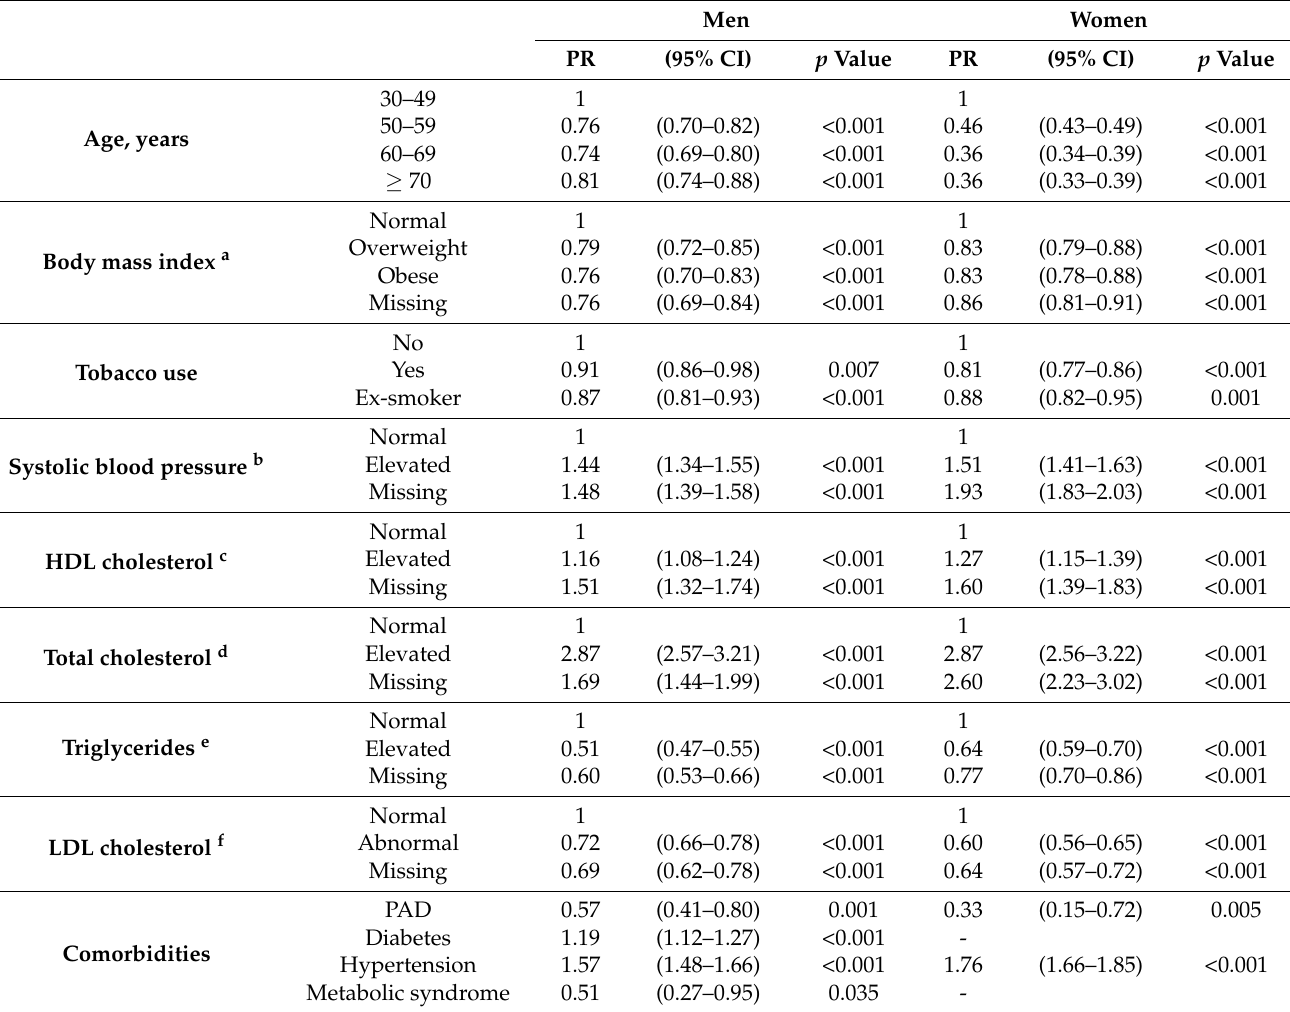
Table 6. Multivariable Poisson regression, prevalence ratios (PRs) for diagnostic inertia, by